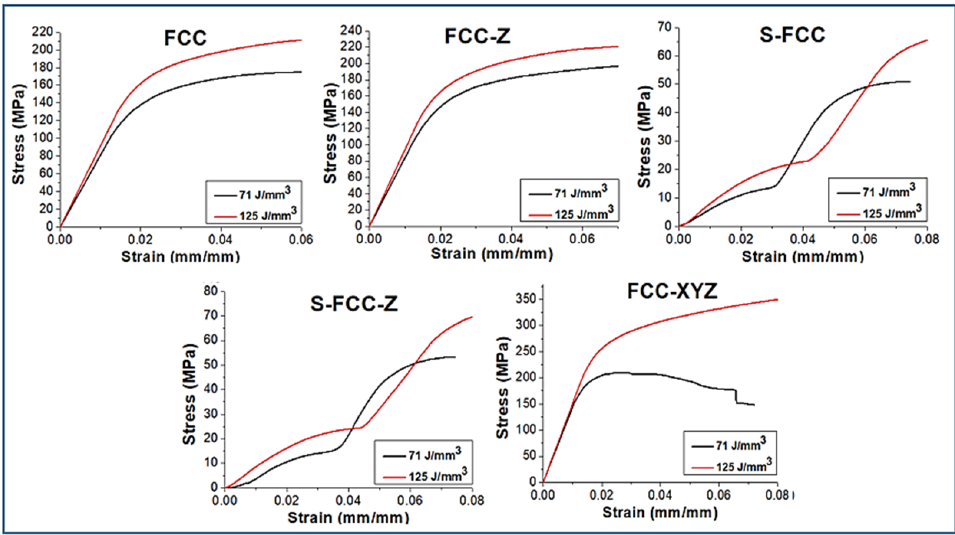
Figure 11. The comparison of flexural stress–strain curve of FCC-based lattices affected by laser energy densities.